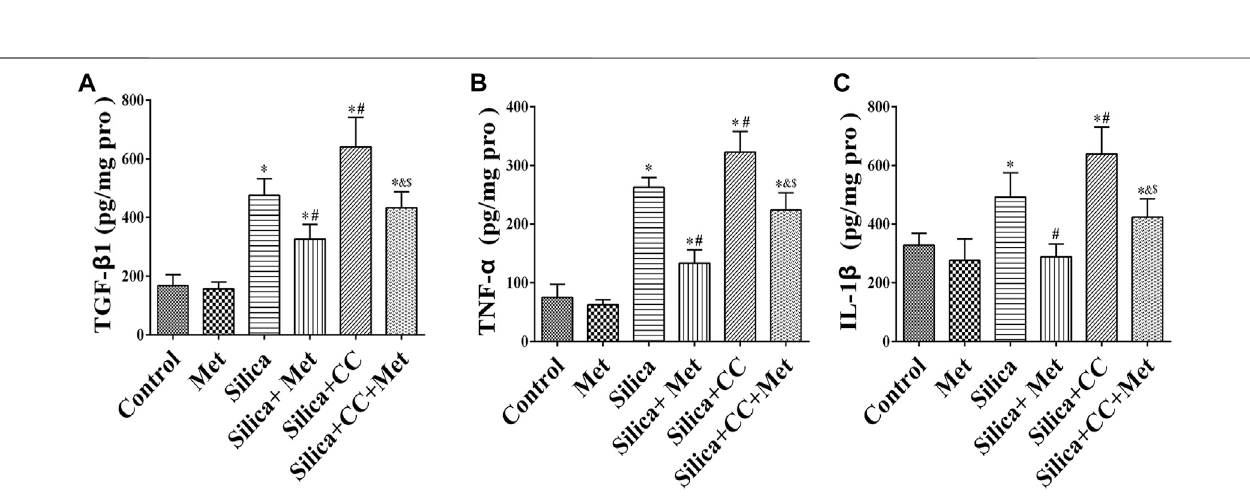
FIGURE 6 | Metformin reduces the expression level of in fl ammatory factors by silica particles in HBECs. The expression level of (A) TGF- β 1, (B) TNF- α , and (C) IL- 1 β detected by ELISA. All the data are presented as mean ± SD ( n (cid:2) 3 for each experimental group). * p < 0.05, compared to the negative control group; # p < 0.05, compared to silica group; & p < 0.05, compared to Silica + Met group; $ p < 0.05, compared to Silica + CC group. TGF- β 1, transforming growth factor- β 1; TNF- α , tumor necrosis factor- α ; IL-1 β , interleukin-1 β ; Pro, protein; Met, metformin; CC, Compound C.